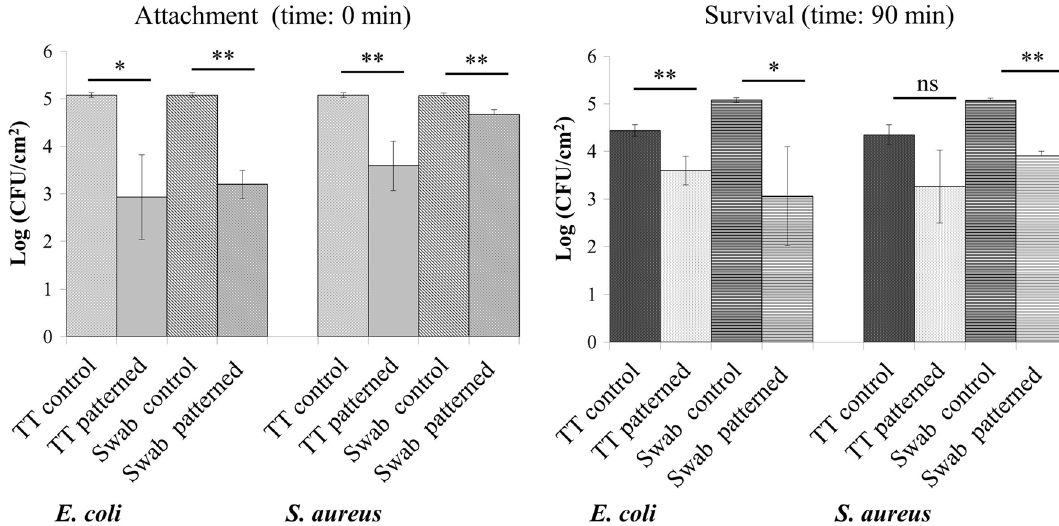
Figure 7. Touch-transfer (TT) and Swab assays. Attachment and survival of E. coli and S. aureus on a PP patterned film after 0 and 90 min of incubation, respectively, according to the Touch-transfer and Swab assays. Bars represent average bacterial counts expressed as log (CFU/cm 2 ). ns no significant. *p < 0.05. **p < 0.01.